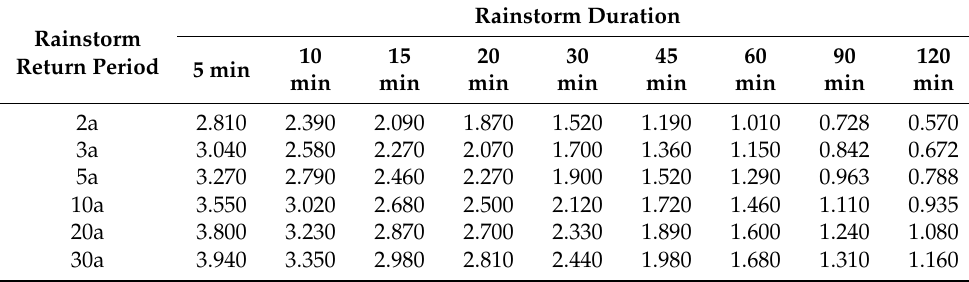
Table 5. Same as Table 4 but for RCP4.5 scenario (units: mm/min).